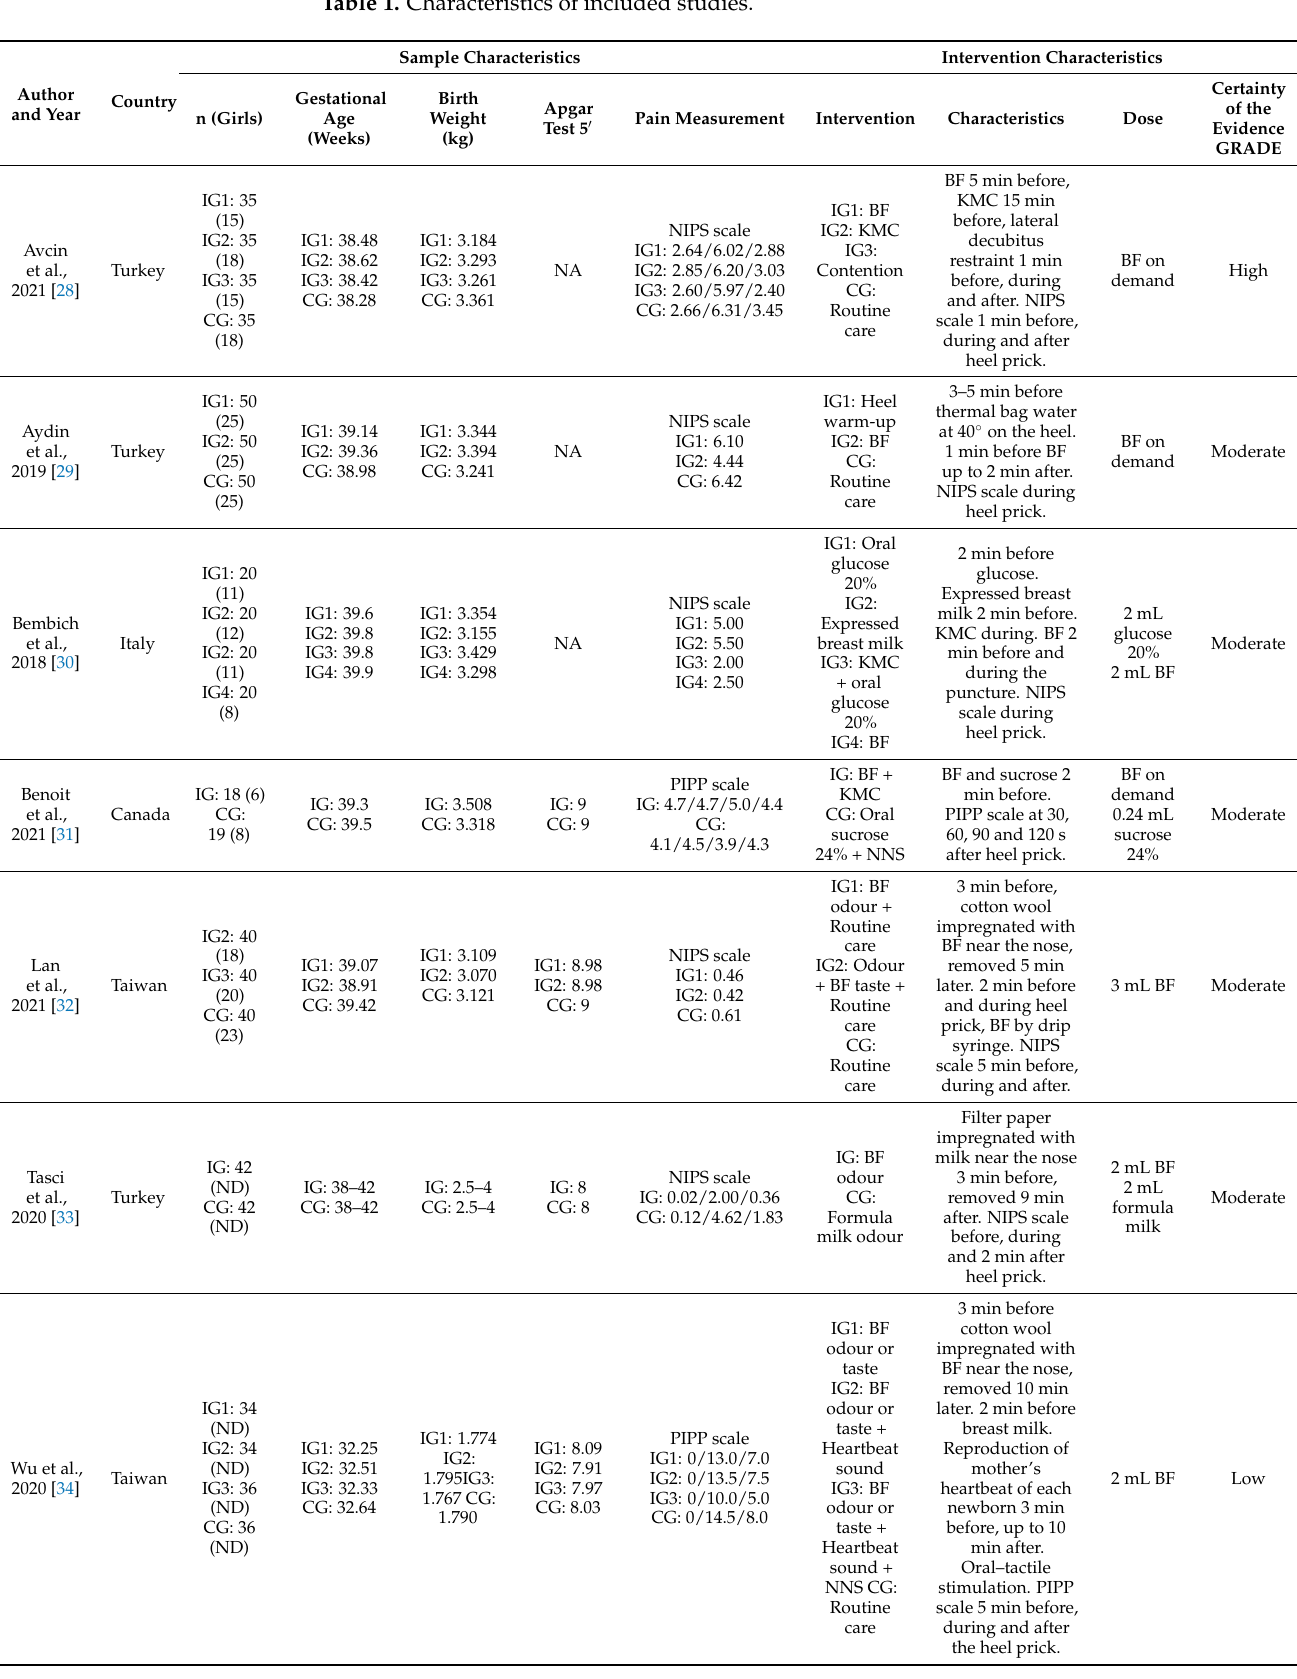
Table 1. Characteristics of included